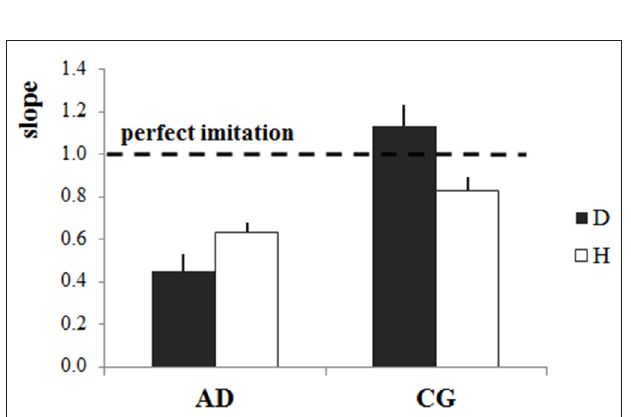
FIGURE 4 | Accuracy of imitation: slopes of the linear regression model. Mean slope values ( ± stardard error) for each stimulus (dot-D and human demonstrator-H) and for both groups (Alzheimer’s disease patients—AD, control group—CG). The horizontal dotted line indicates the perfect imitation of the stimulus velocity, and refers to the slope of the perfect imitation line in Figure 2